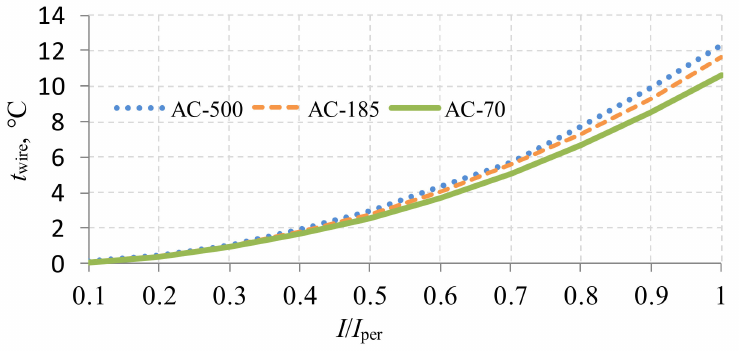
Figure 4. Relationship between the wire temperature and the flowing current for several types of wires (AC-500, AC-184, AC-70). Ambient temperature is 0 ◦ C, wind speed is 4